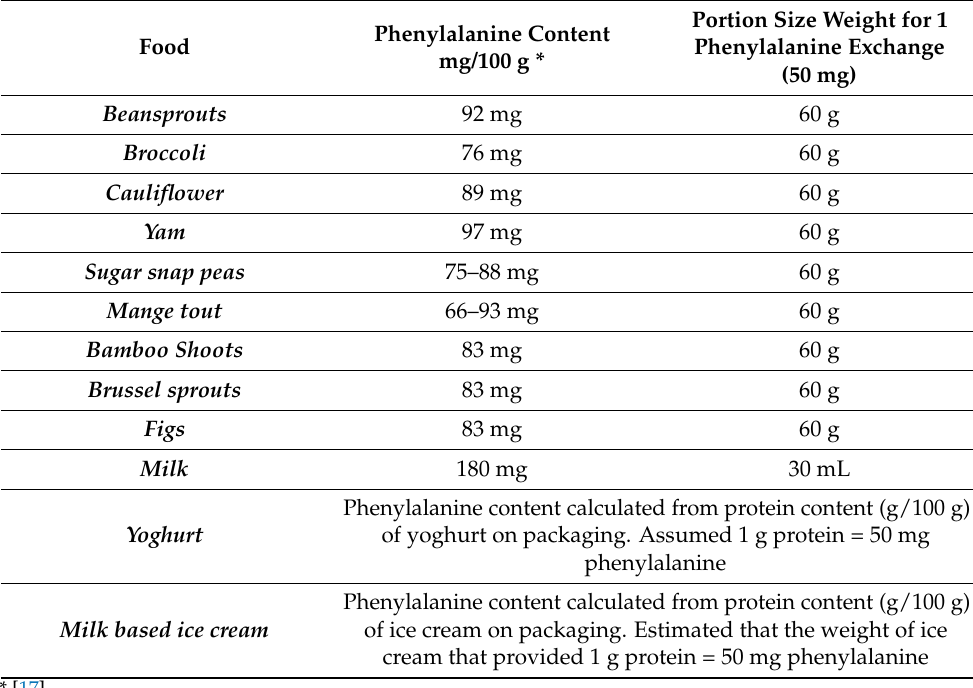
Table 1. Phenylalanine content (mg/100 g), and 50 mg phenylalanine exchange portion sizes for fruits and vegetables and milk sources given in the intervention period of this study.